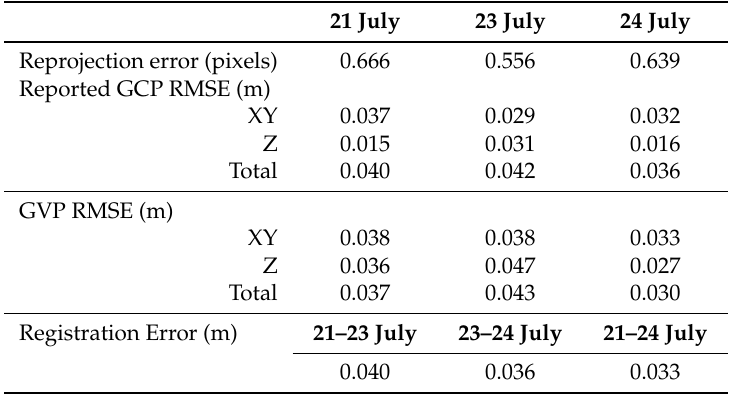
Table 2. Reported and calculated errors of point clouds and combined error of point cloud pairs. Reprojection error and GCP RMSE are calculated within Photoscan, calculation of GVP RMSE is described in Section 3.4. The registration error is the mean of the total RMSE from two point clouds.